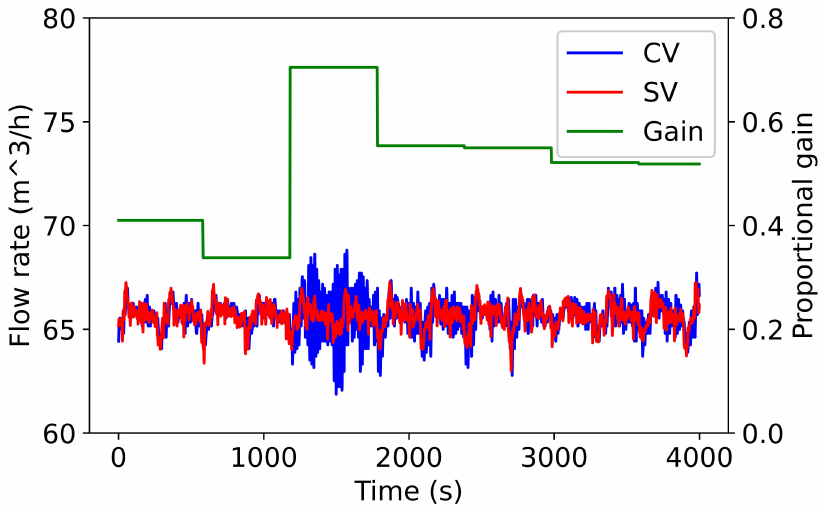
Figure 10. An example of Agent A’s behavior during industrial testing, showing the proportional gain, CV, and